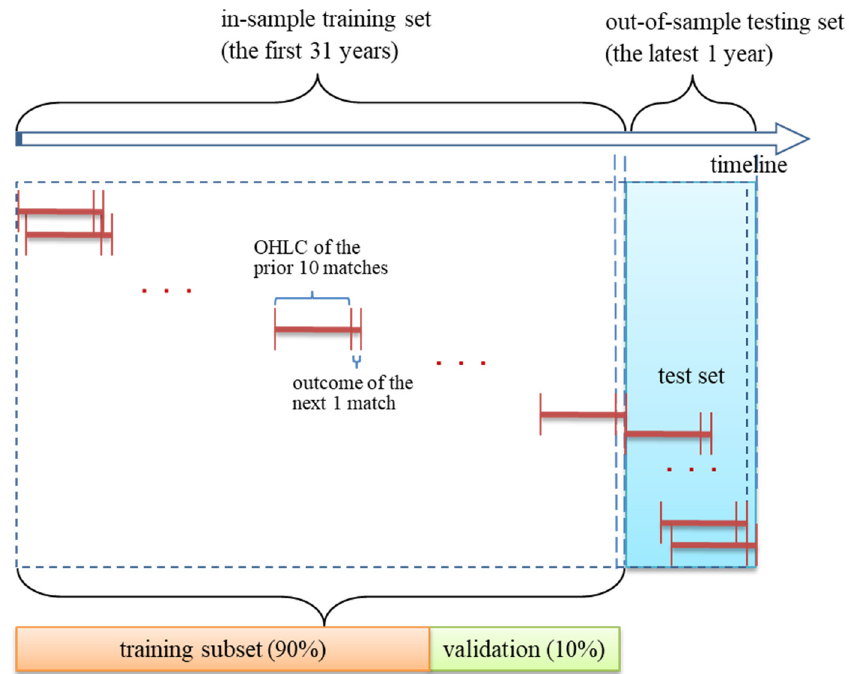
Figure 7. Data segmentation.